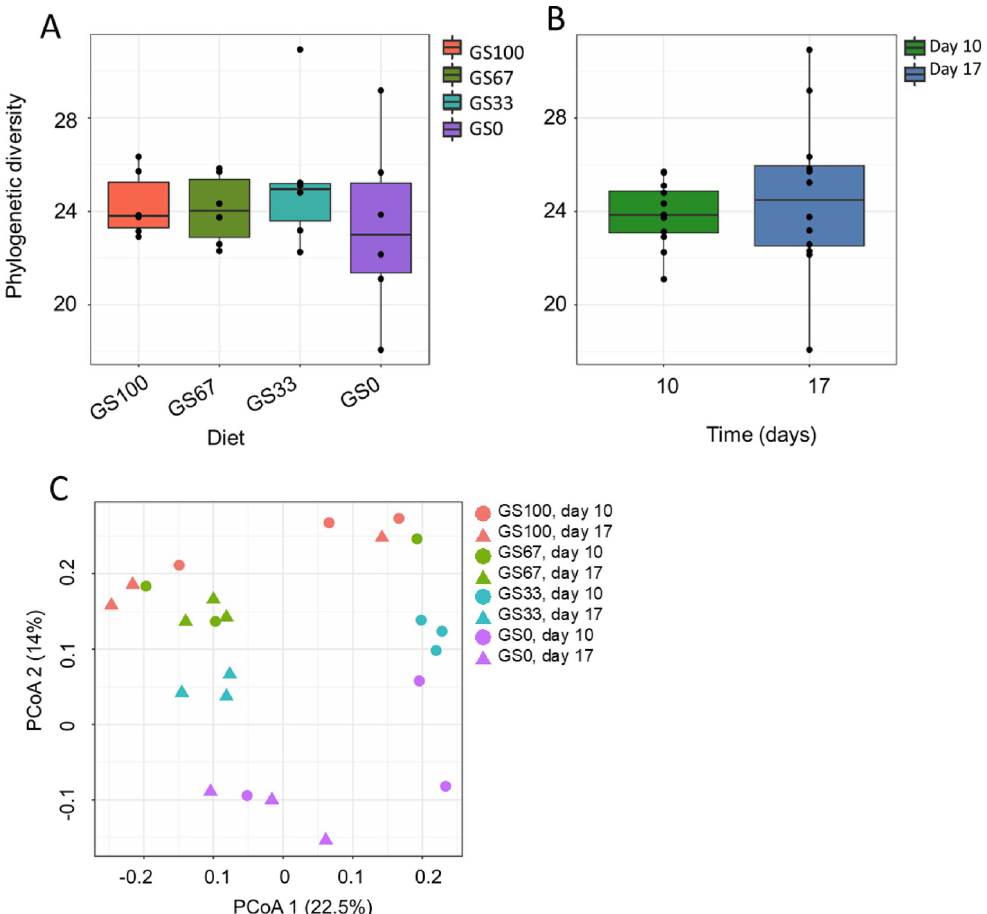
Fig 2. Alpha and beta diversity analysis of rumen bacterial communities. Phylogenetic diversity (PD) of rumen bacterial communities associated to different ratios of (A) grass and maize silage and (B) different time points. Sample codes indicate the number of days that the diet had been fed (10 or 17) and the different grass and maize silage proportions in the diet, for example GS100 is 100% grass silage. Principal co-ordinate analysis (PCoA) analysis of bacterial community composition in rumen fluid samples (n = 24) using (C) the unweighted UniFrac distance metric. The percentage of variation explained is indicated on the respective